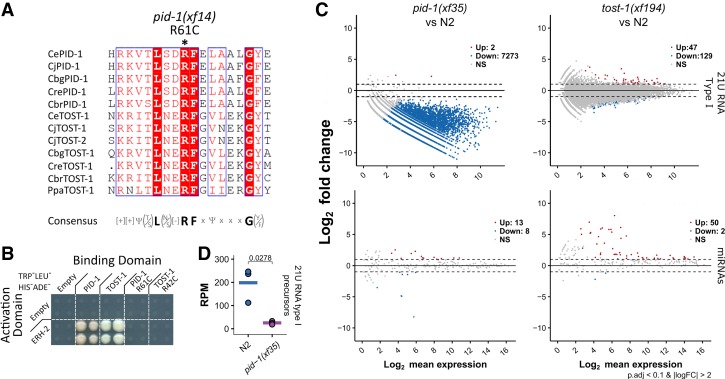
PID-1 and TOST-1 define different PETISCO functions. (A) Alignment of a short region of PID-1 and TOST-1 homologs from different nematodes. A conserved arginine residue was found to be mutated in pid-1(xf14), as indicated. A consensus sequence is presented below the alignment. Alignment was performed with Muscle version 3.8 (Edgar 2004), and representation was performed with ESPrit version 3.0 (Robert and Gouet 2014). (B) Y2H interaction assay of PID-1, TOST-1, and PID-1/TOST-1 carrying the corresponding arginine mutation found in pid-1(xf14). High-stringency plates (TRP−LEU−HIS−ADE−) were used. For other conditions, see Supplemental Figure S4D. (C) Global levels of type I 21U RNA precursors in wild-type (N2) and pid-1(xf35) nongravid adults. Values were obtained from CIP-RppH-treated smRNA libraries. (RPM) Reads per million mapped reads. Individual data points of three independent replicates are shown, and the horizontal bar represents the mean. Significance was tested with Student's t-test, and P-values are indicated in the graph. (D) Pairwise differential gene expression of type I 21U RNAs and miRNAs in pid-1(xf35) and tost-1(xf194) versus wild-type (N2) control. Samples consisted of gravid adult individuals. Red and blue dots indicate up-regulated and down-regulated transcripts, respectively.